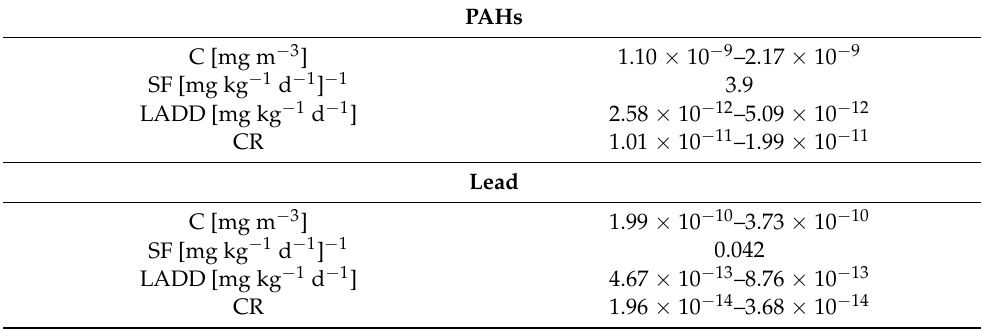
Table 5. Cancer risk for PAHs and Lead from inhalation, with particulate soot emissions in the range of 8–15 (mg m − 3 ) on a daily